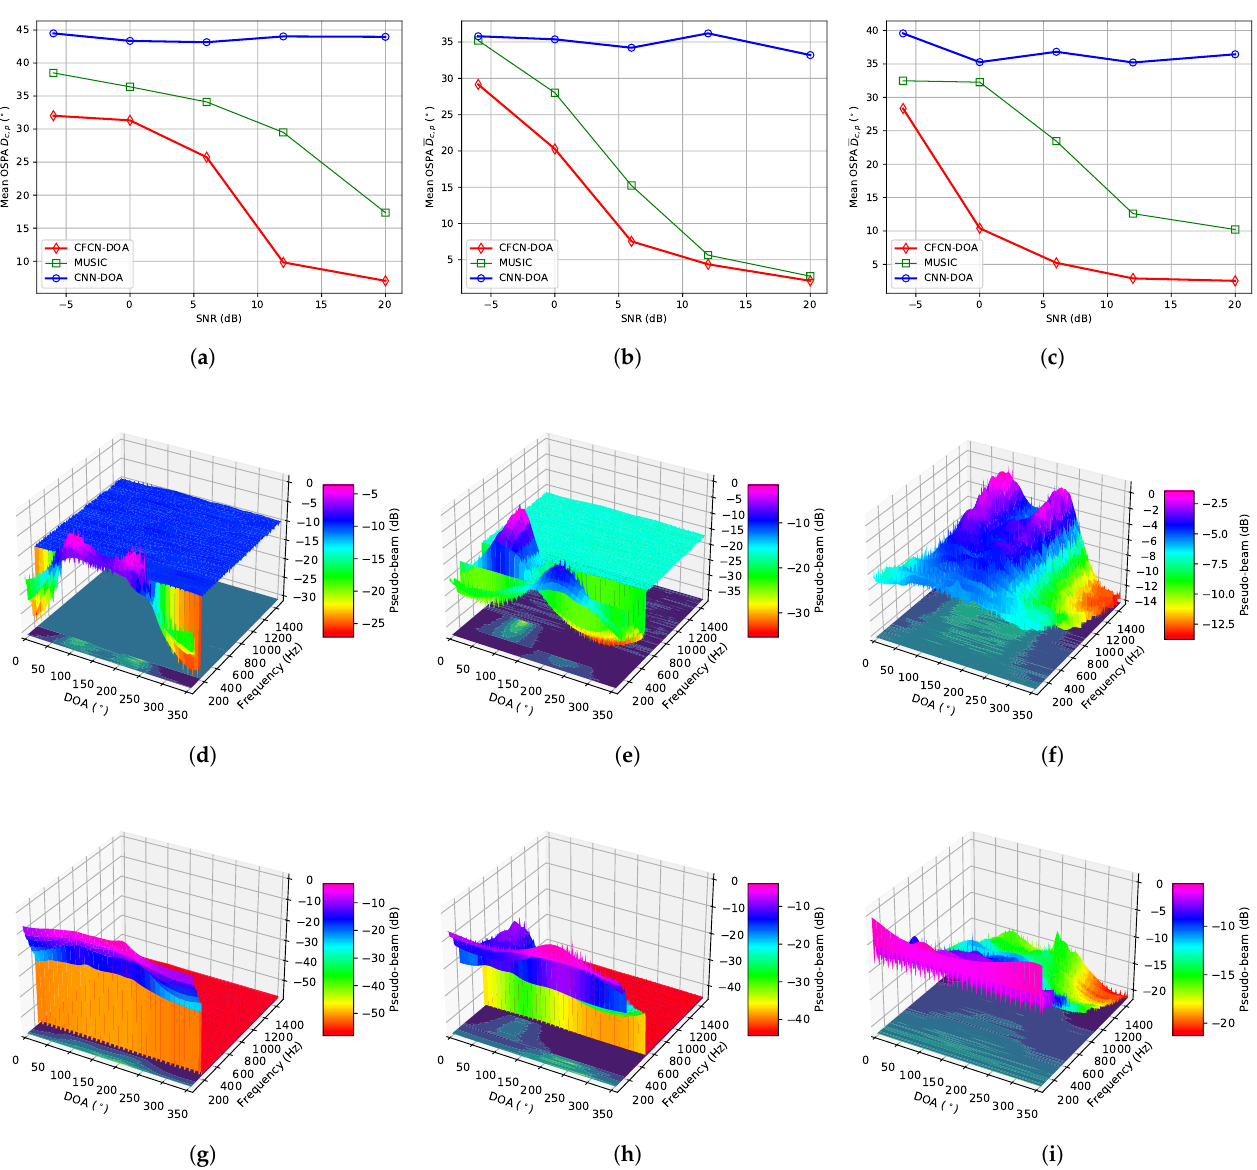
Figure 6. The results of the simulation under the dual-source condition. ( a ) The mean OSPAs under the overlapping low-frequency condition. ( b ) The mean OSPAs under the non-overlapping frequency condition. ( c ) The mean OSPAs under the overlapping full-frequency condition. ( d ) Space-frequency pseudo-spectrum of CFCN under the conditions: overlapping low-frequency and SNR = 12 dB. ( e ) Space-frequency pseudo-spectrum of CFCN under the conditions: non-overlapping frequency and SNR = 6 dB. ( f ) Space-frequency pseudo-spectrum of CFCN under the conditions: overlapping full-frequency and SNR = 0 dB. ( g ) Space-frequency pseudo-spectrum of MUSIC under the conditions: overlapping low-frequency and SNR = 12 dB. ( h ) Space-frequency pseudo-spectrum of MUSIC under the conditions: non-overlapping frequency and SNR = 6 dB. ( i ) Space-frequency pseudo-spectrum of MUSIC under the conditions: overlapping full-frequency and SNR = 0